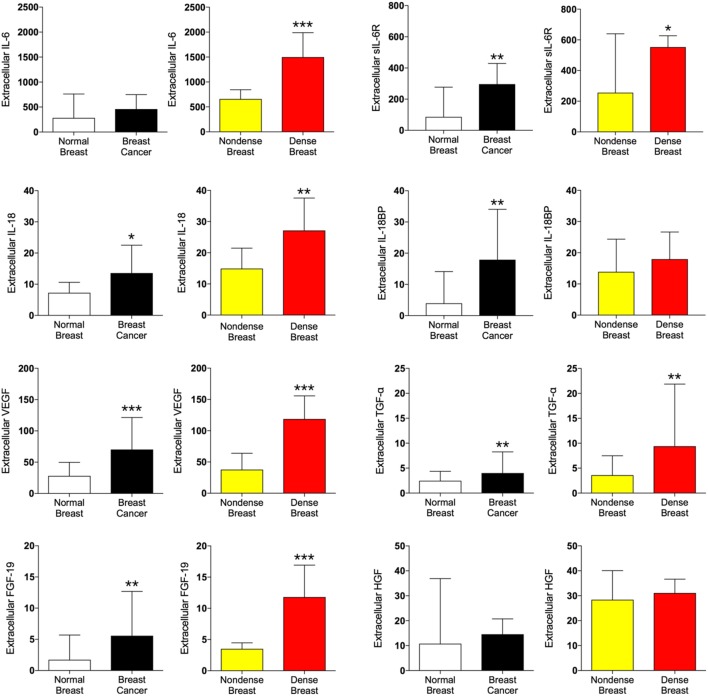
Extracellular levels of pro-tumorigenic proteins in vivo in breast cancers and healthy normal breast tissue with different densities. 51 women were investigated using microdialysis; 12 breast cancer patients underwent microdialysis before surgery. One catheter was inserted into the breast cancer (black bars) and another into adjacent normal breast tissue (white bars). 39 postmenopausal healthy volunteer women, attending the regular mammography-screening program and were categorized as either having dense or non-dense breasts underwent microdialysis of their left breast. Women with dense breasts (n = 20) are depicted in red and women categorized as non-dense (n = 19) are depicted in yellow. Data represent protein abundance in linear values (2NPX as described in the Section “Materials and Methods”). Graphed data are presented as median with 95% CI (*P < 0.05, **P < 0.01, ***P < 0.001).